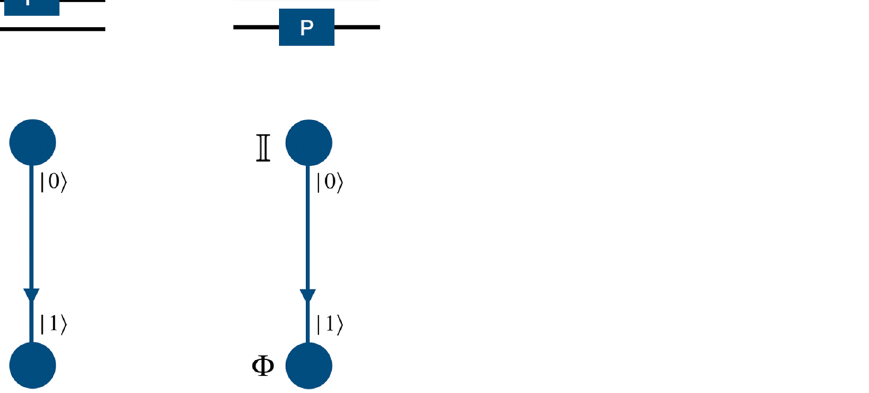
Figure 2. Schematic illustration for the realization of phase gate on the computational basis of two-qubit system using a single particle quantum walk on two point position space using position dependent coin operation on the real qubit.